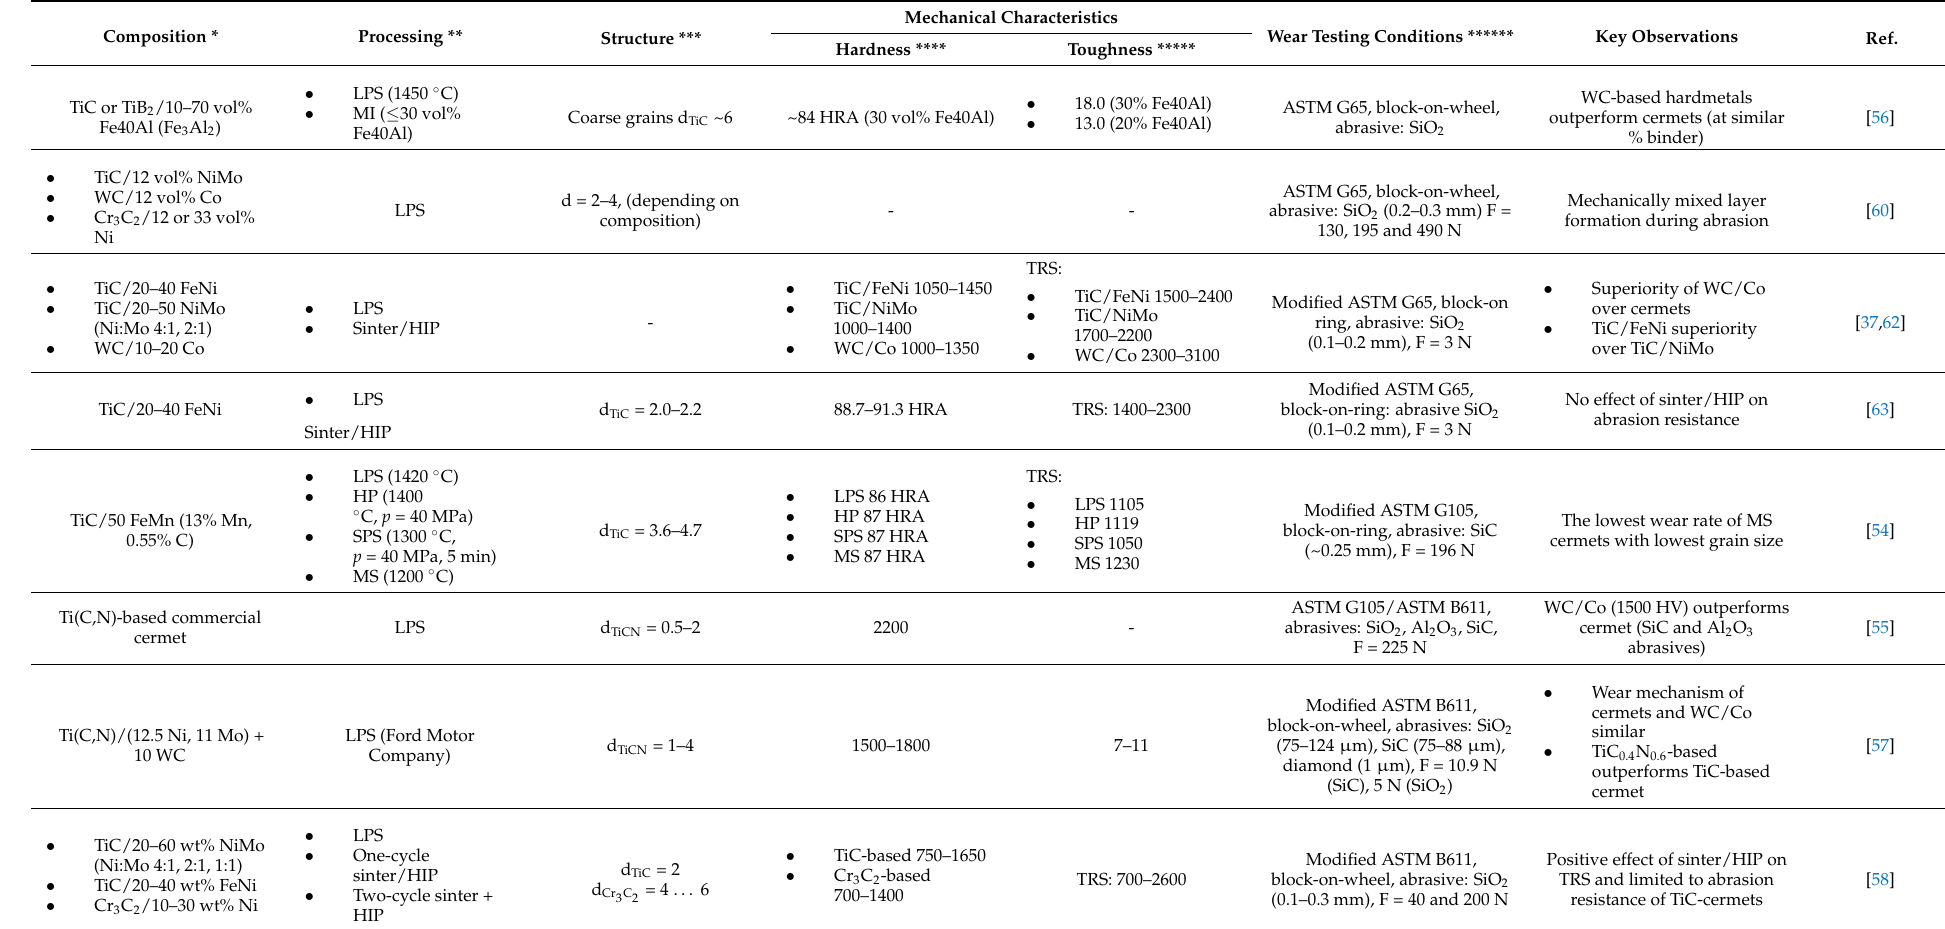
Table 2. Summary of composition, processing, structural and mechanical characteristics and three-body abrasive wear testing conditions of